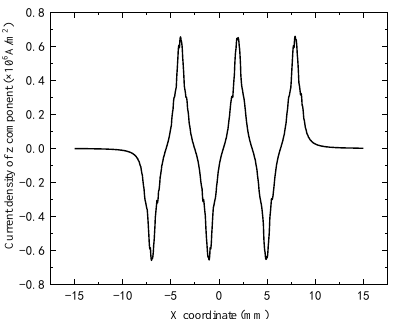
Figure 11. Magnetic flux density distribution in the aluminum plate.